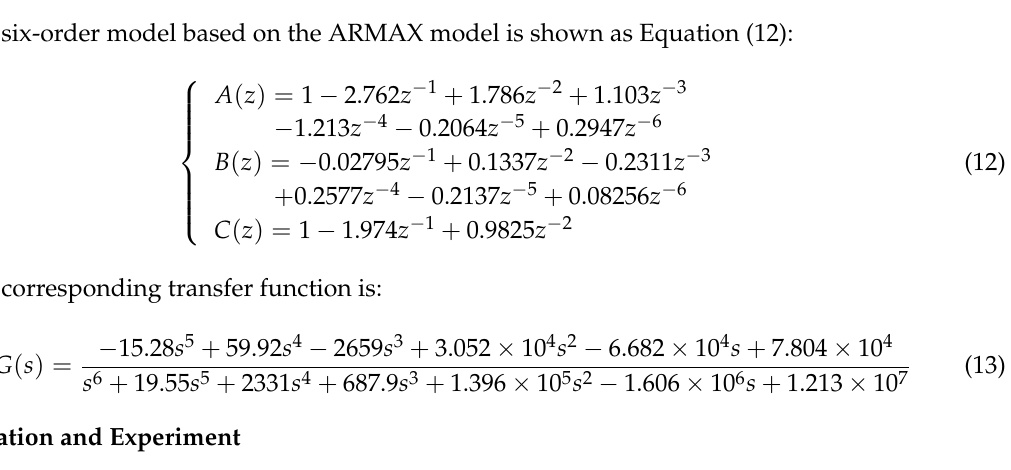
Figure 7. System identification contrast diagram.